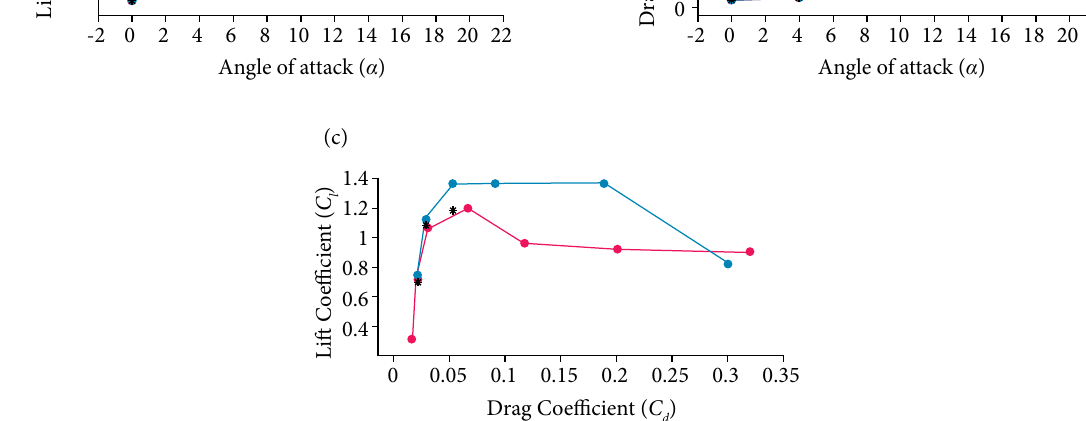
Figure 3. Validation of lift and drag coefficient.